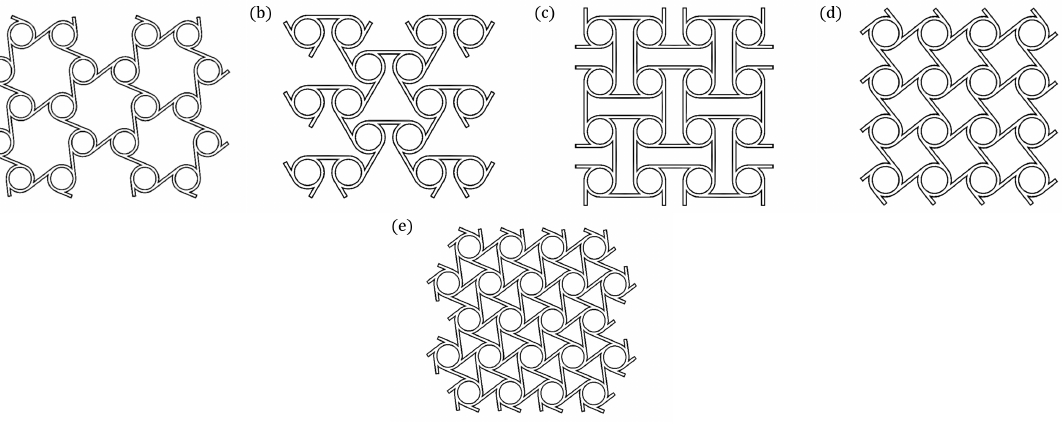
Figure 1. Circular node ring chiral structures: ( a ) tri; ( b ) antitri; ( c ) tet; ( d ) antitet; ( e ) hex.